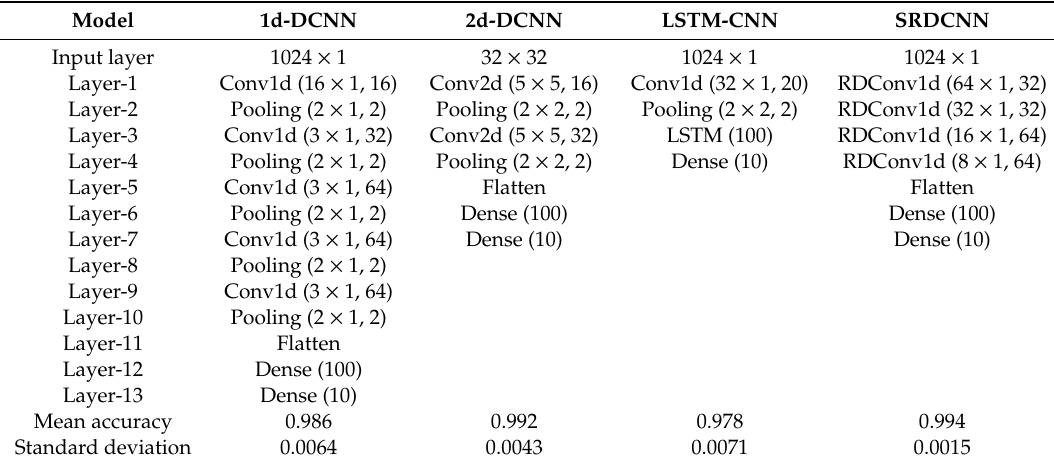
Table 2. Structure parameters and performance indicators of